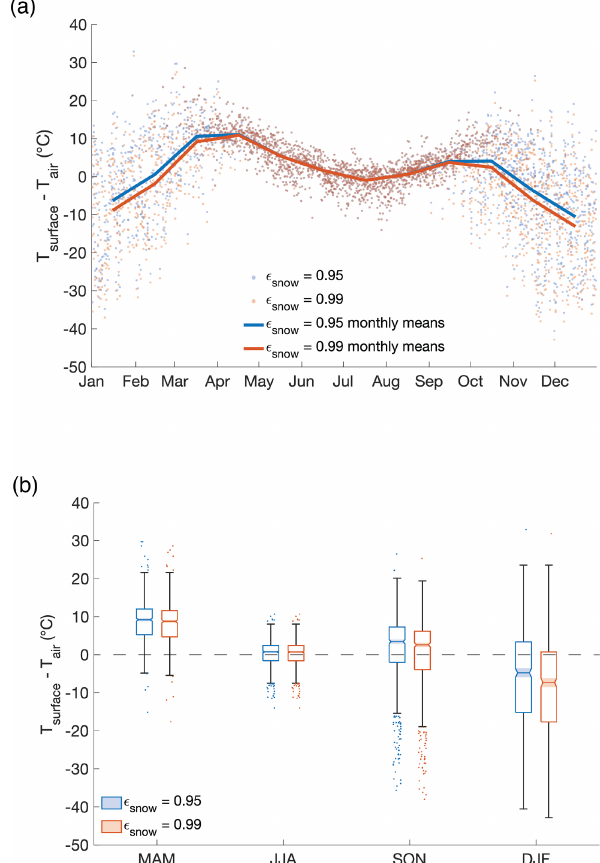
Figure 10. Seasonal differences between surface and 2m air tem- peratures calculated from ERA5 and Divide AWS data. All data are for 12:00 to control for diurnal effects. Shaded notched areas in panel (b) indicate the 95% confidence interval for the median tem- perature difference. Horizontal dashed line in panel (b) indicates where surface temperatures and air temperatures are equivalent. All surface temperatures > 0 ◦ C were assigned a value of 0 ◦